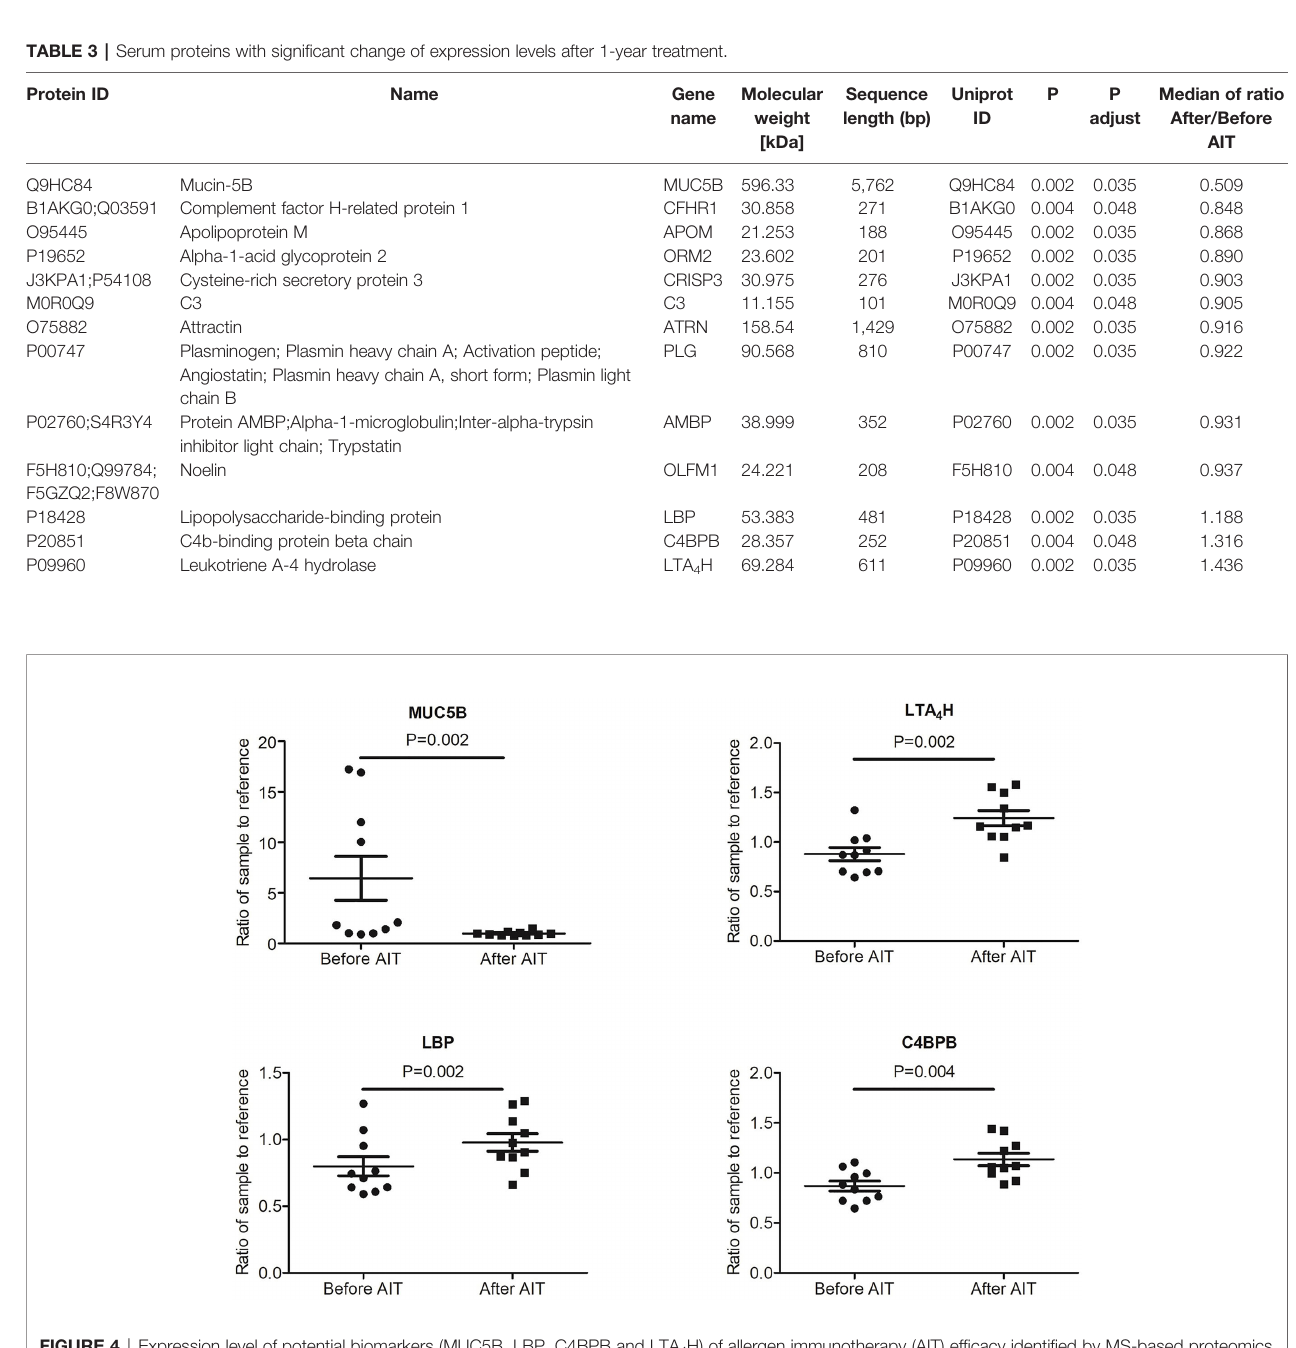
FIGURE 4 | Expression level of potential biomarkers (MUC5B, LBP, C4BPB and LTA 4 H) of allergen immunotherapy (AIT) ef fi cacy identi fi ed by MS-based proteomics in AIT responder